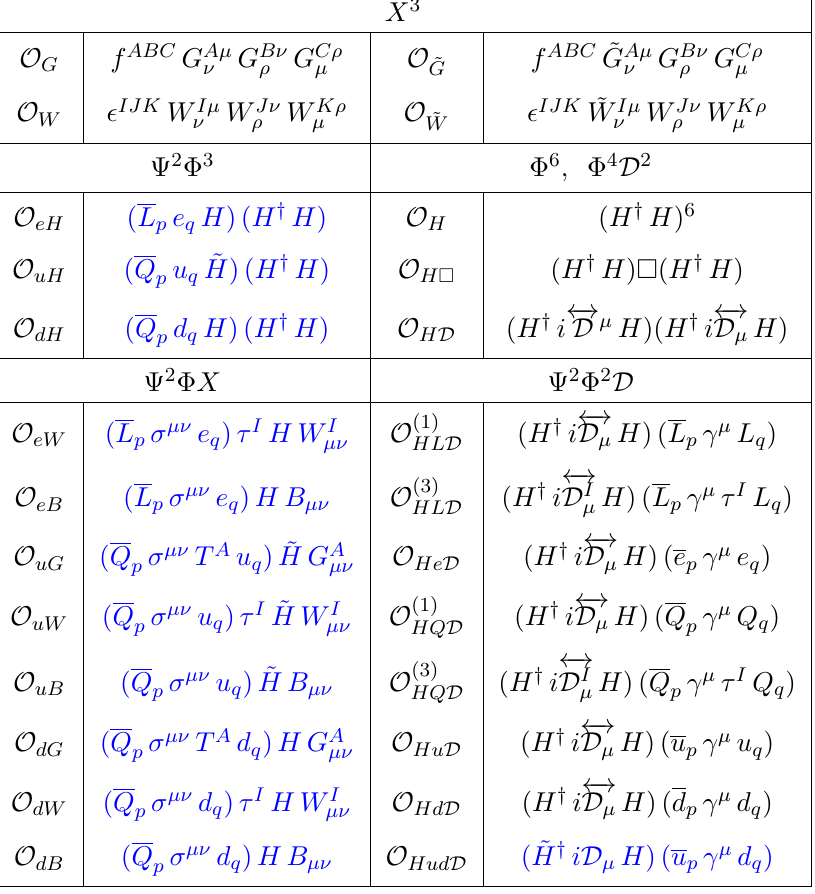
Table 30 . SMEFT dimension 6 operators. Here, T A and τ I are SU(3) and SU(2) generators respectively. A, B, C = 1 , 2 , · · · , 8 and I, J, K = 1 , 2 , 3 . p, q = 1 , 2 , · · · , N f are flavour indices. Operator naming convention has been adopted from